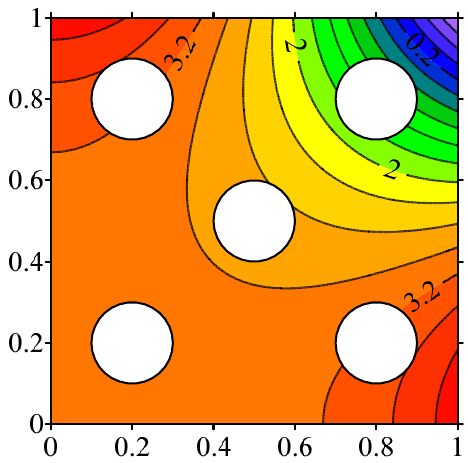
Figure 9. Distribution of the numerical solution for test 1 in case 4.